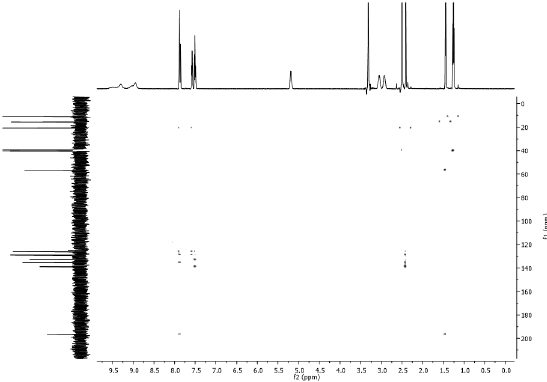
Figure 15. 1 H– 13 C HMBC spectrum of 3-MEC ( 4 ); 500MHz, DMSO-d 6 , RT.